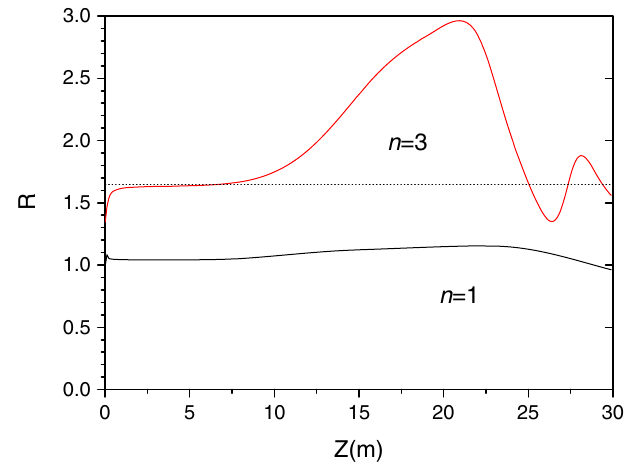
FIG. 6. The enhancement of the harmonic radiation [dashed line: result of Eq.